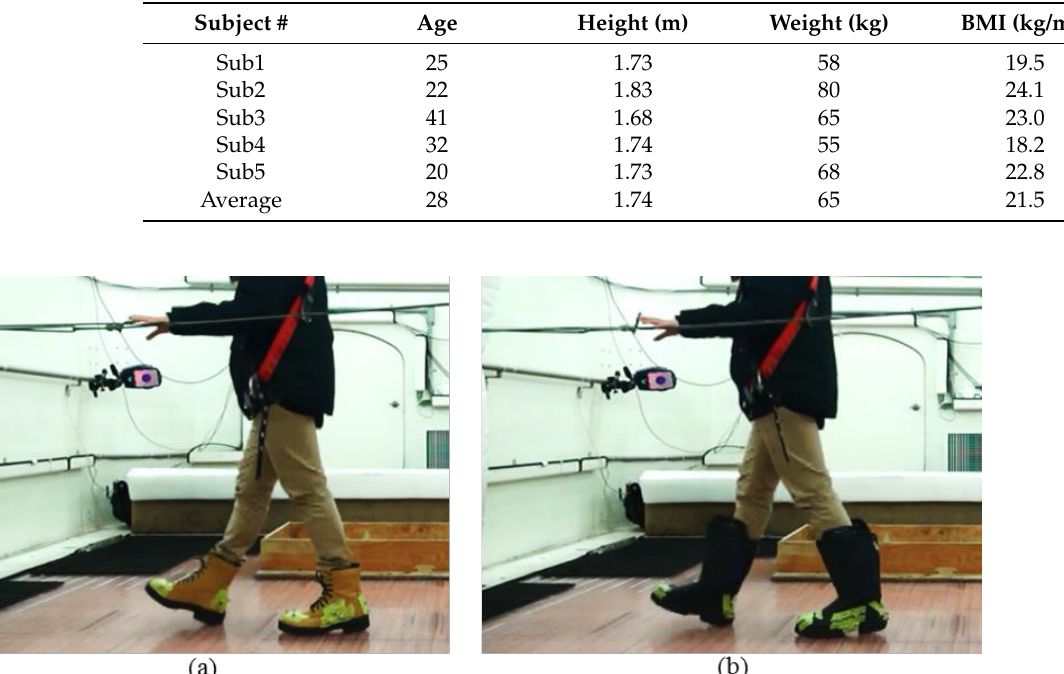
Figure 5. Participant walking in the WinterLab with ( a ) F1 and ( b ) F5.